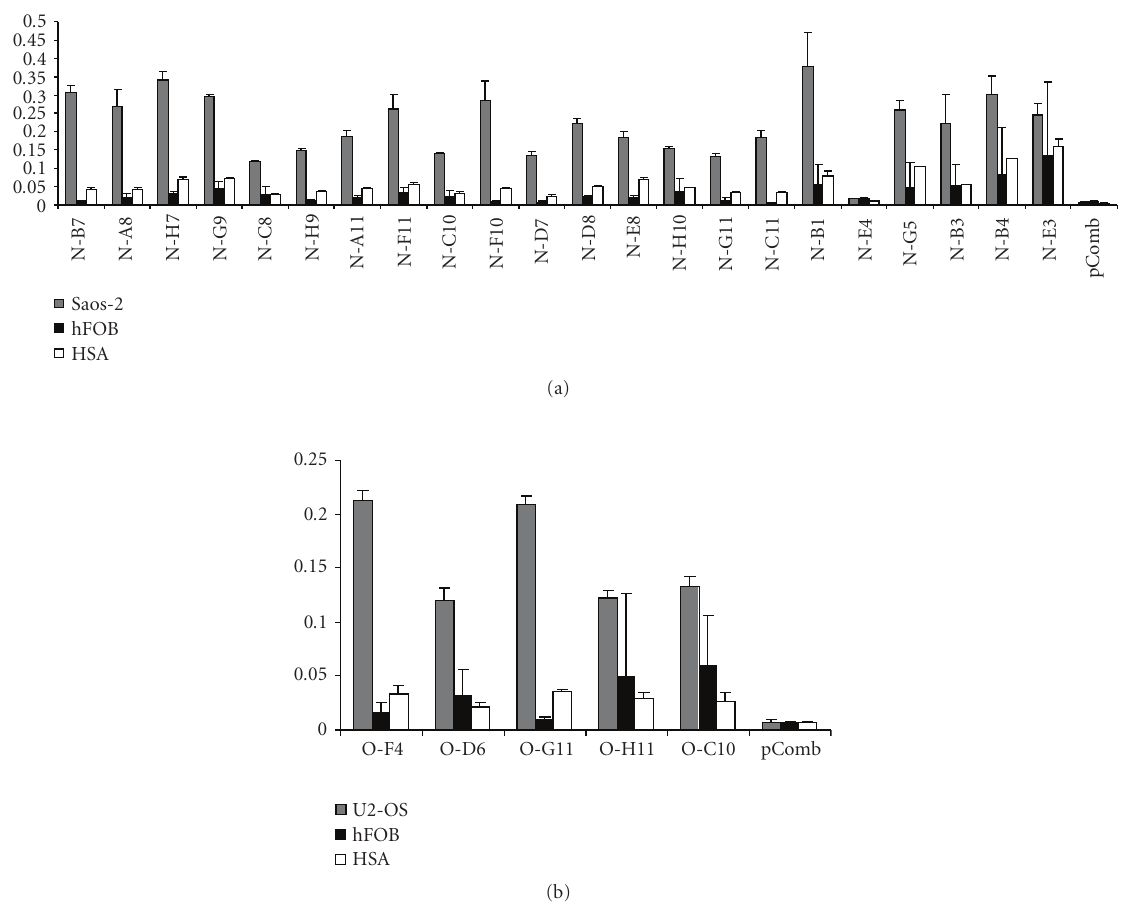
Figure 1: Selection of Fab clones able to recognize osteosarcoma cell protein extracts. Protein extracts from Saos-2 cells (horizontal line bars, panel (a)), U2-OS cells (horizontal lines, panel (b)), and h FOB 1.19 (normal human osteoblast, black bars, both panels) were used to coat a 96-well plate. E. coli supernatants from the N system (panel (a)) or the O system (panel (b)) Fab clones were added to the plate. After washing, the bound Fabs were detected using rabbit anti-HA antibody followed by an HRP-conjugated anti-rabbit antibody. The experiments were performed in triplicate. The Fabs were also added to HSA- (human serum albumin) coated wells (diagonal line bars, both panels) as a negative control. Supernatant from an empty vector E. coli culture was also used as negative control (pComb). The absorbances were measured at 405 nm.